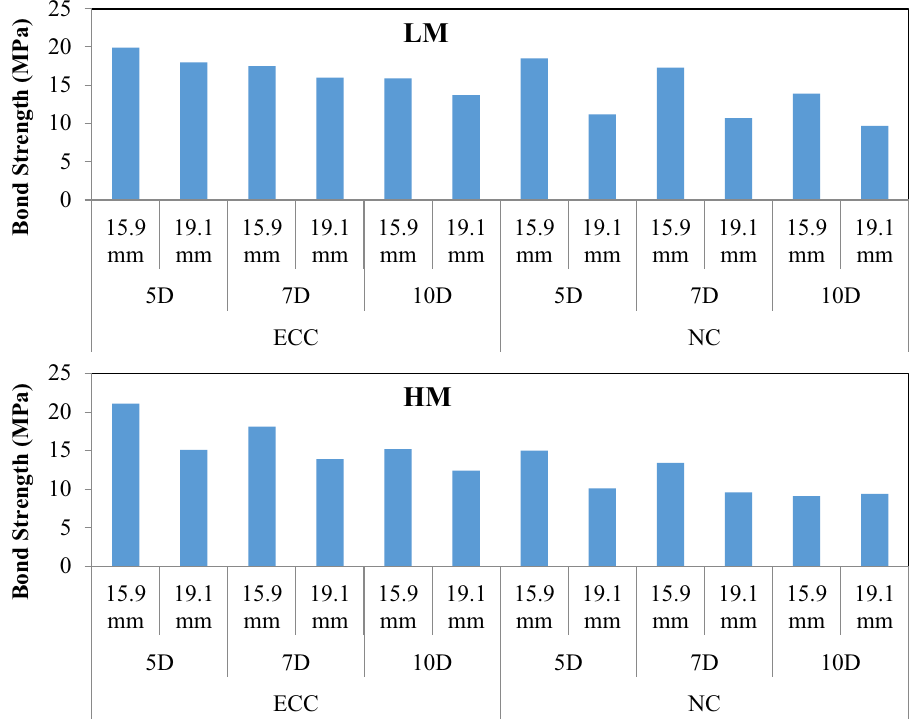
Fig. 9 Effect of bar diameter and embedded length on bond strength.